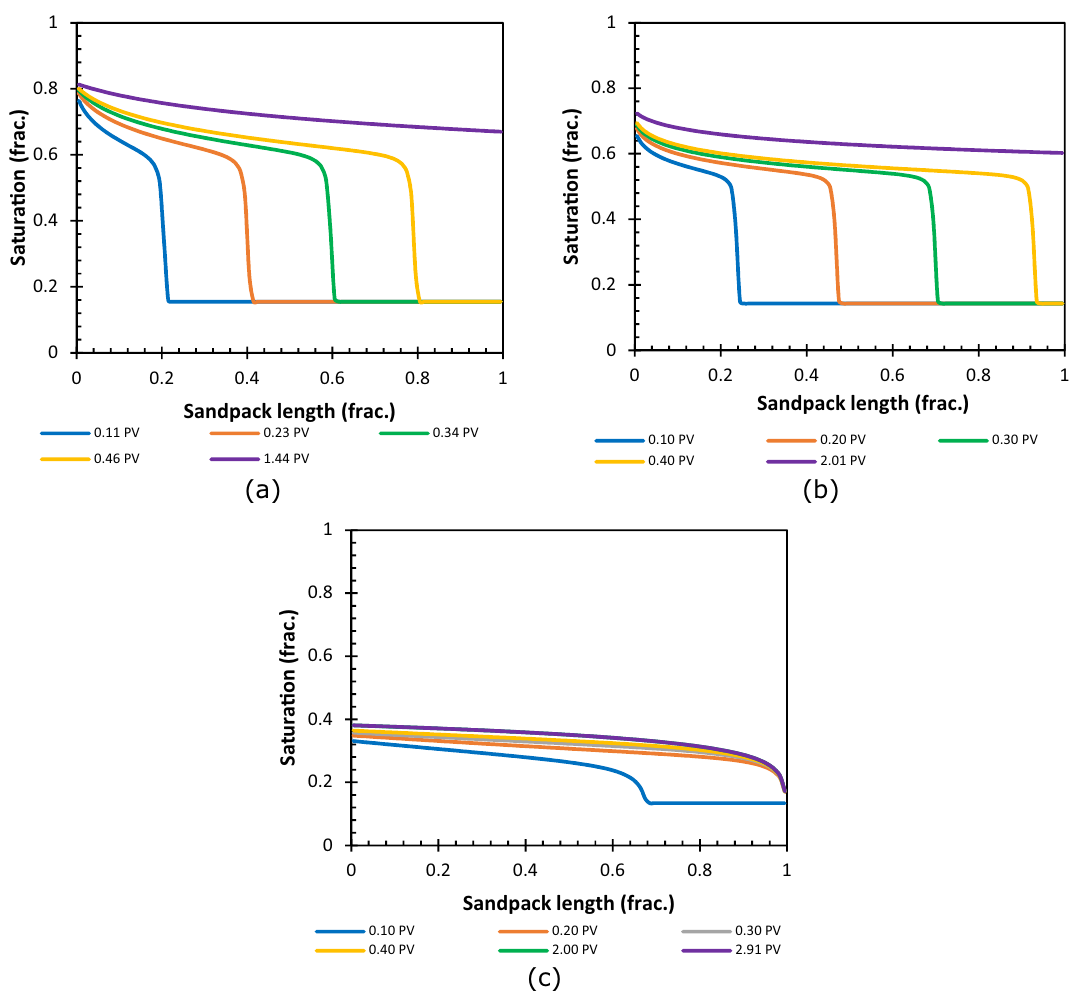
Fig. 13 Saturation profile of motor oil cases along the sandpack column at varying PV intervals with the displacing fluid as a XG 2500 ppm, b XG 1000 ppm and c